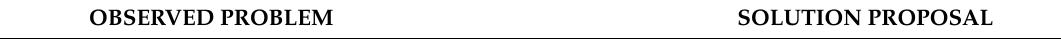
Table 1. Research team